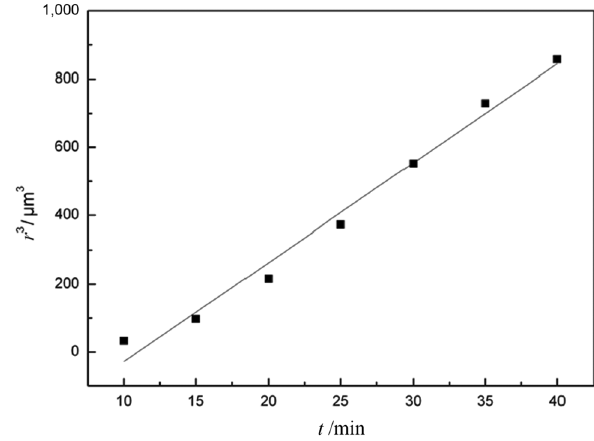
Figure 4: The relationship between r 3 and t of rutile crystals at 1,683